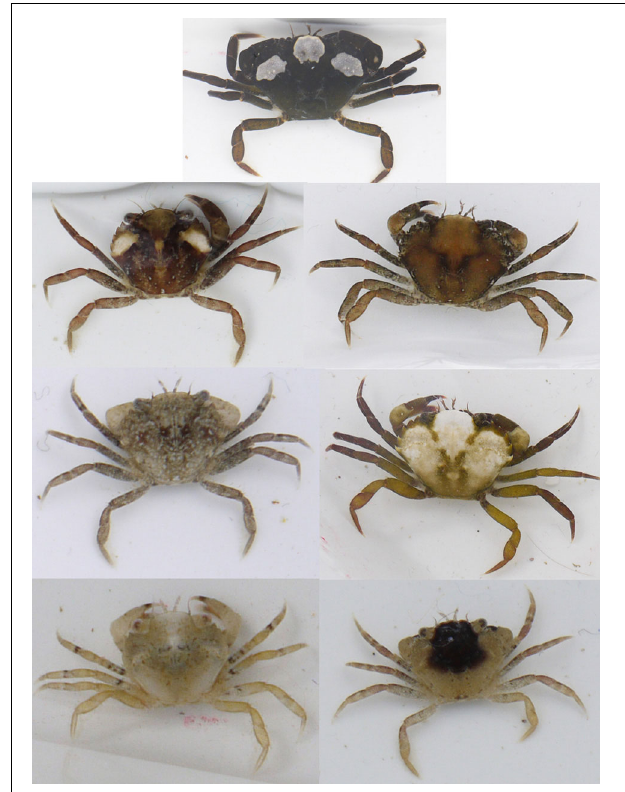
FIGURE 1 | Variation in juvenile shore crabs, showing the considerable differences in color and pattern that exists among individuals. All crabs used in this experiment were between 2.8 and